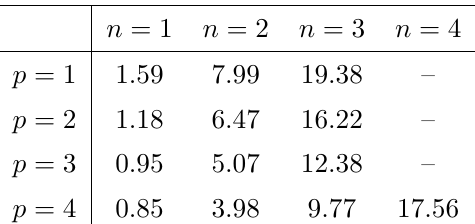
Table 1 . Critical masses for the full Skyrme model with the potential the critical point occurs above m =